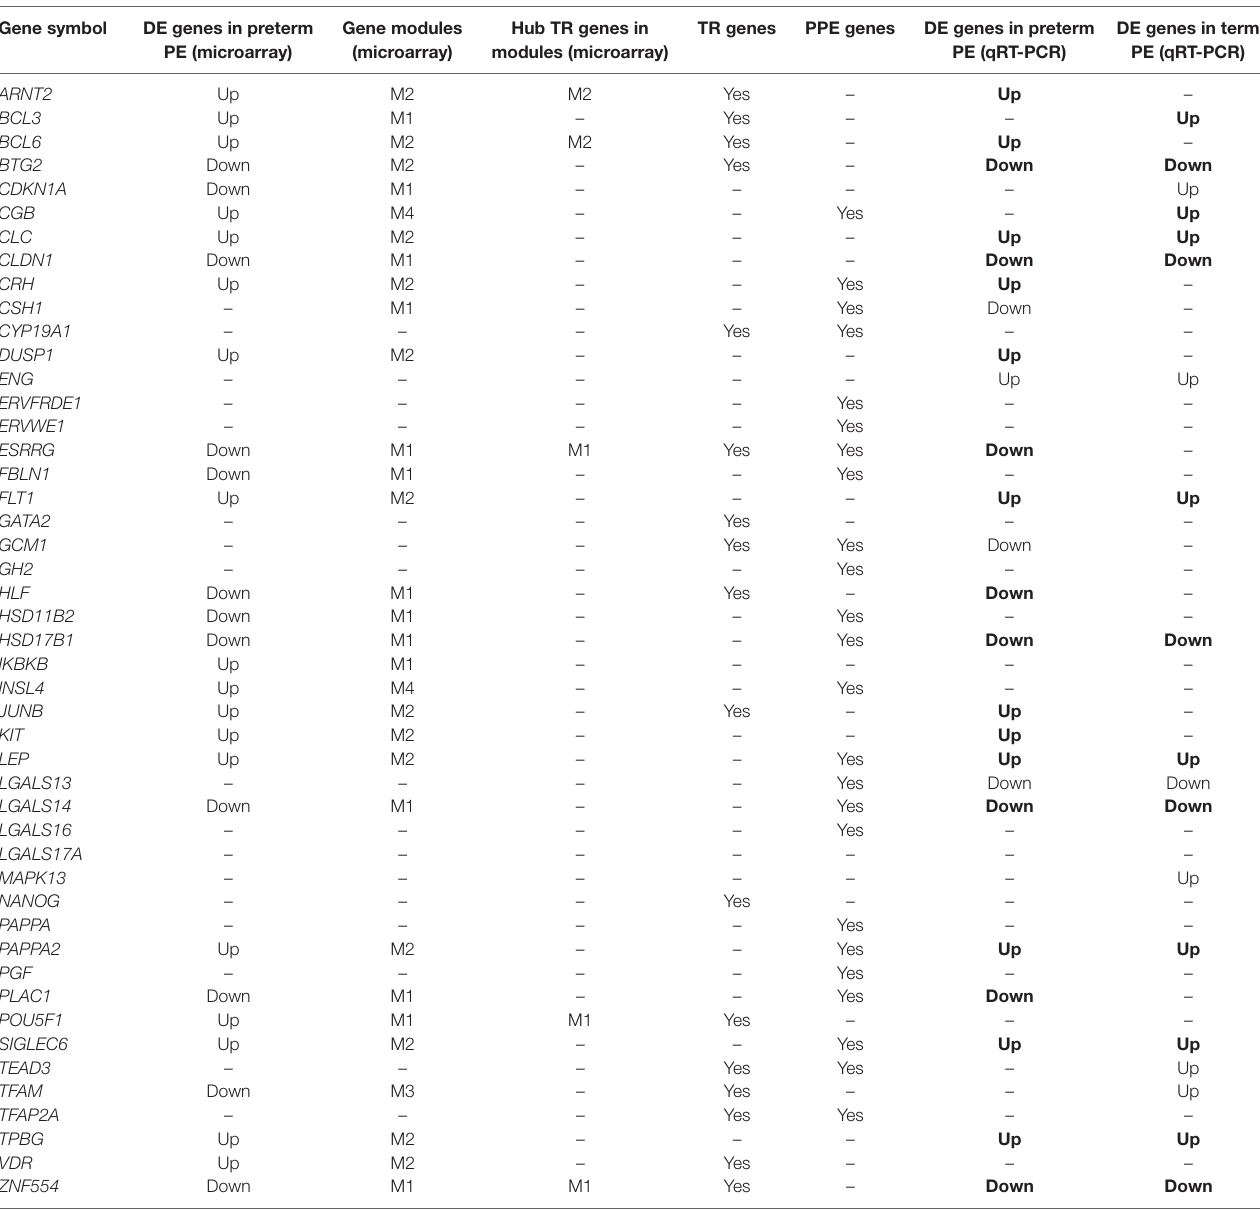
TaBle 3 | Genes included in the placental qRT-PCR validation study. gene